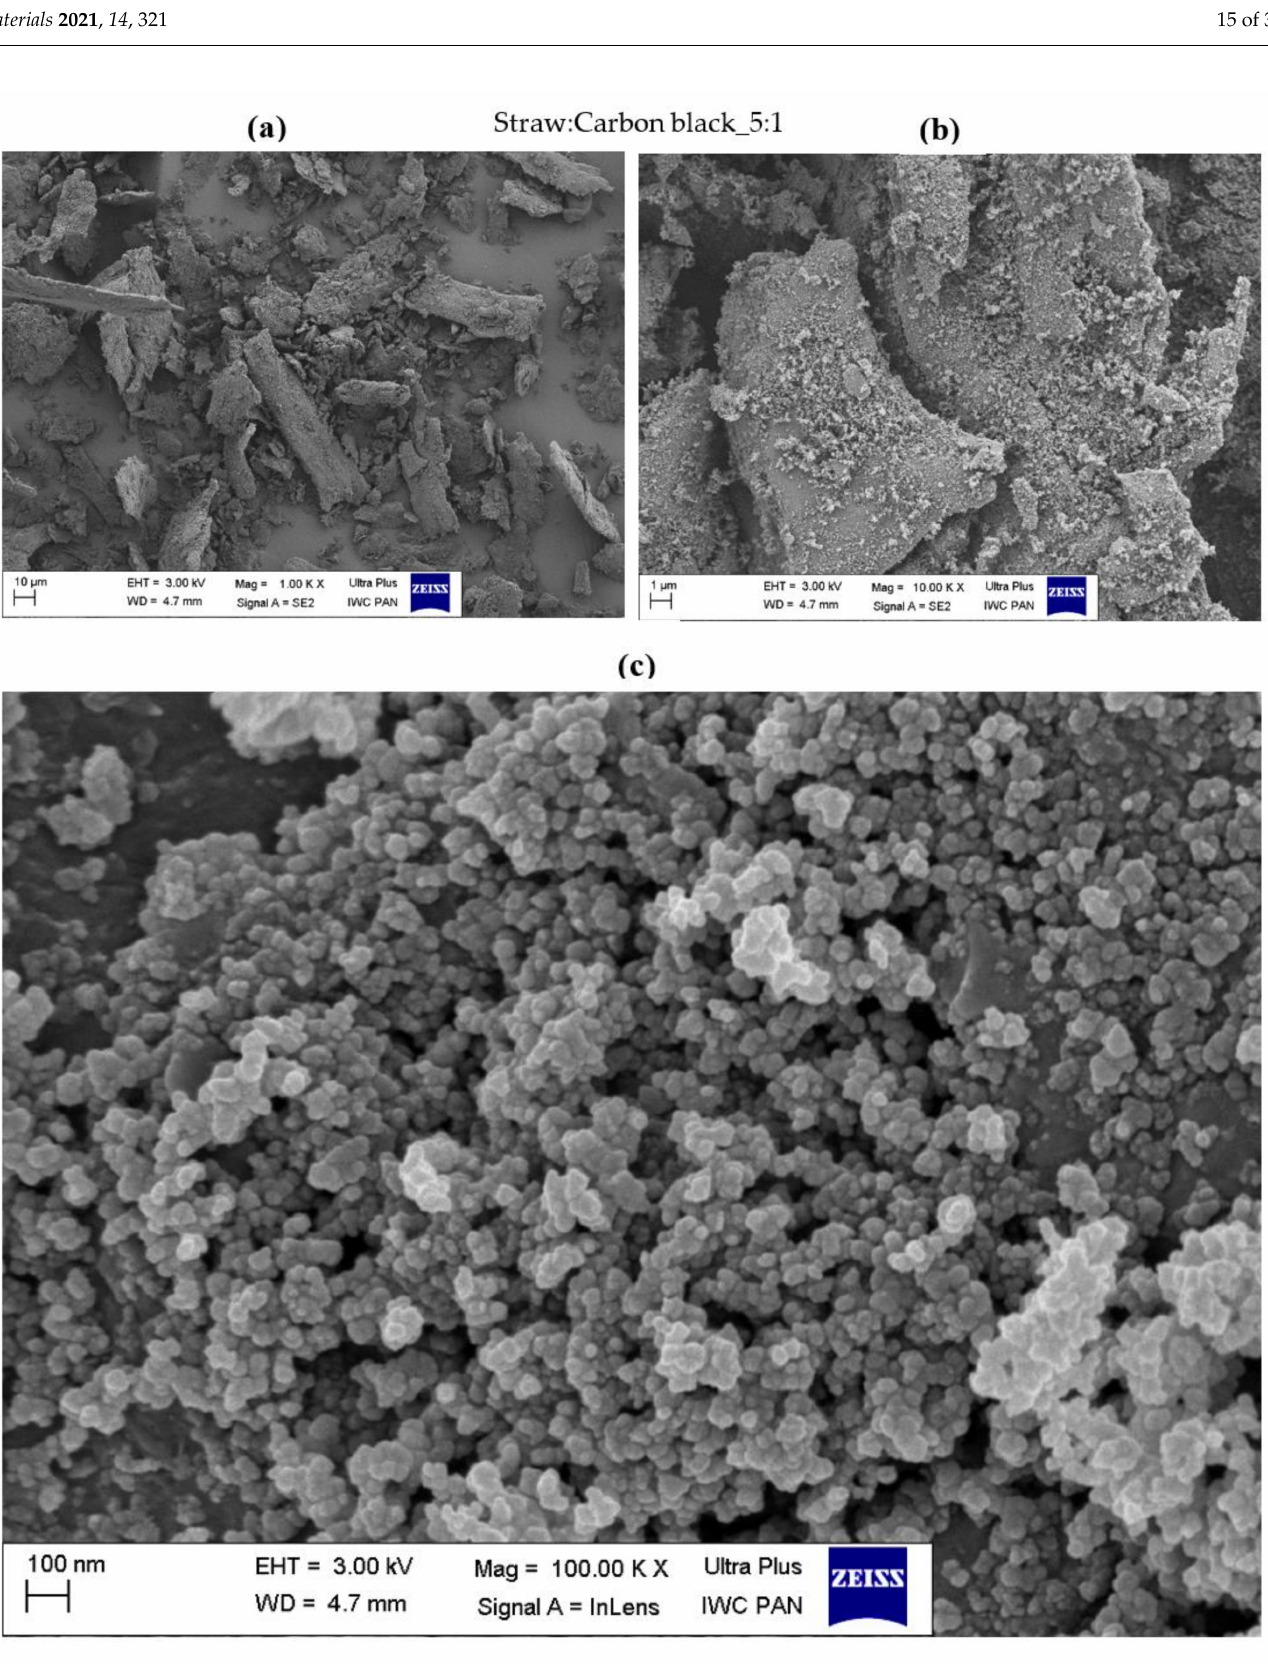
Figure 9. Microscopic images of straw fillers with the addition of carbon black (5:1) at a magnification of ( a ) × 1.00 k, ( b ) × 10.000 k, ( c ) × 100.00